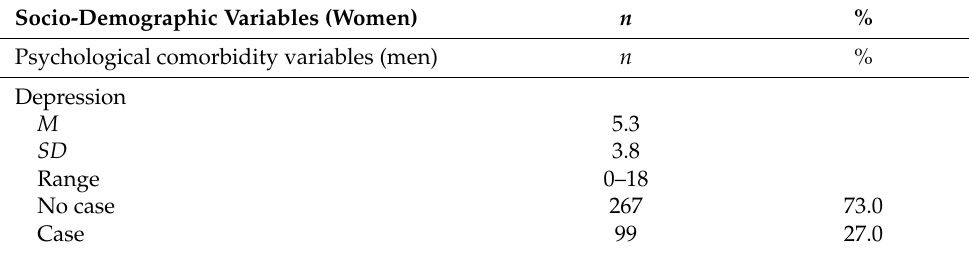
Table 1. Cont . Socio-Demographic Variables